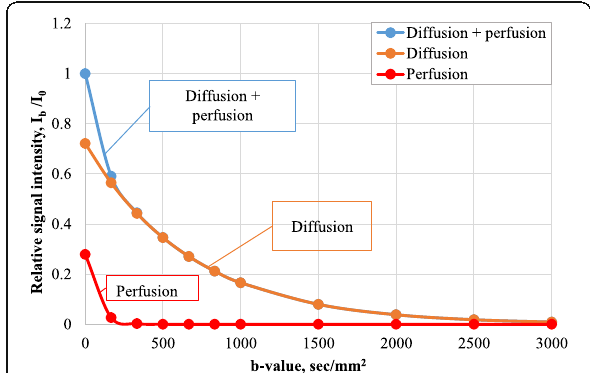
Fig. 2 The relationship between relative signal intensity, b value, and perfusion (according to data from the